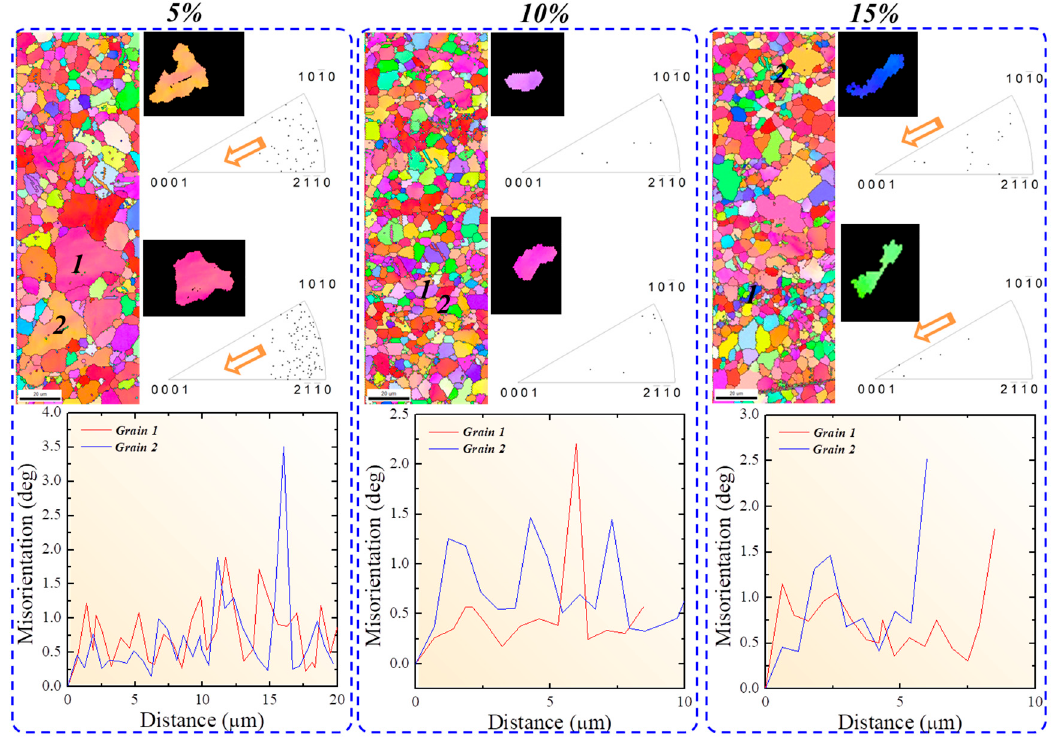
Figure 4. In-crystal misorientation axis (ICMA) measurements of the stretched samples. The misorientation profiles presented in this figure were taken from the grains used for the ICMA measurements.